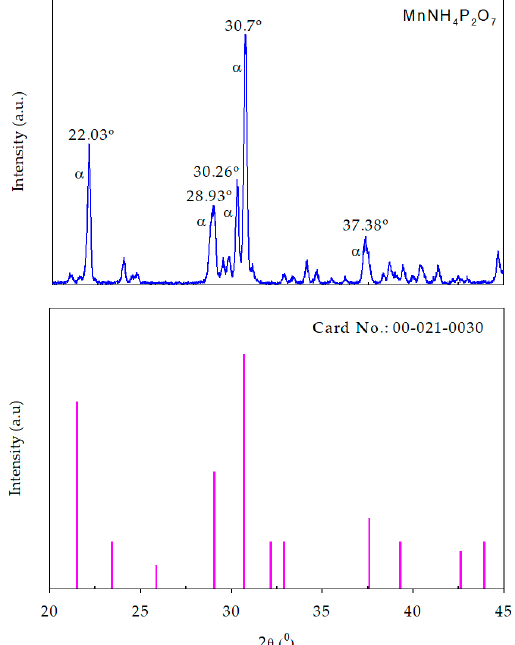
Figure 3. X-Ray Diffraction (XRD) patterns of synthesized manganese violet ( above ) and standard PDF2 pattern ( below ).